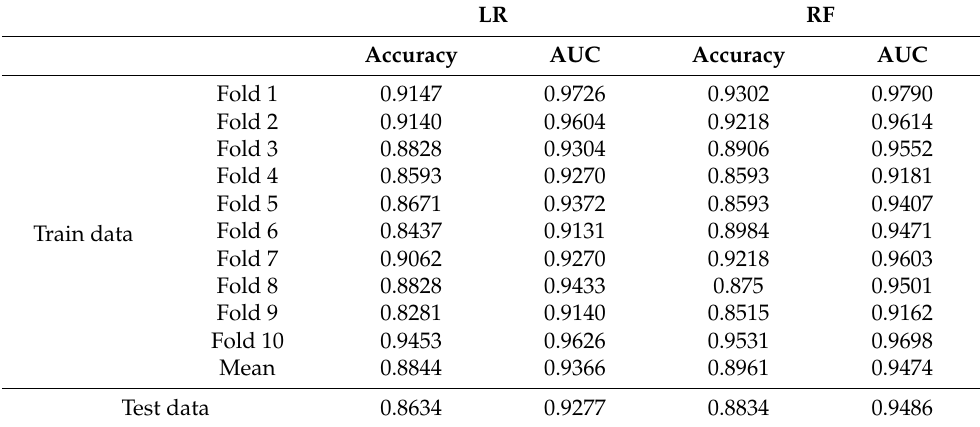
Figure 7. The ROC-AUC values of the predicted flash flood susceptibility models derived from the LR and RF algorithms. Table 1. Classification performance of training and test sets of LR and RF